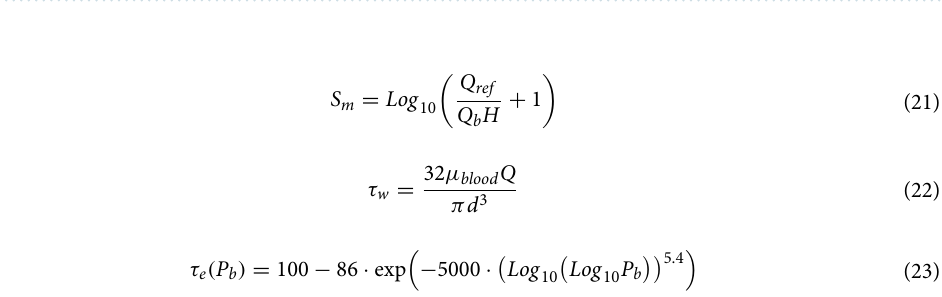
Figure 2. Four-compartment 5-rate-constant model for spatiotemporal modeling of [ 18 F]FDG